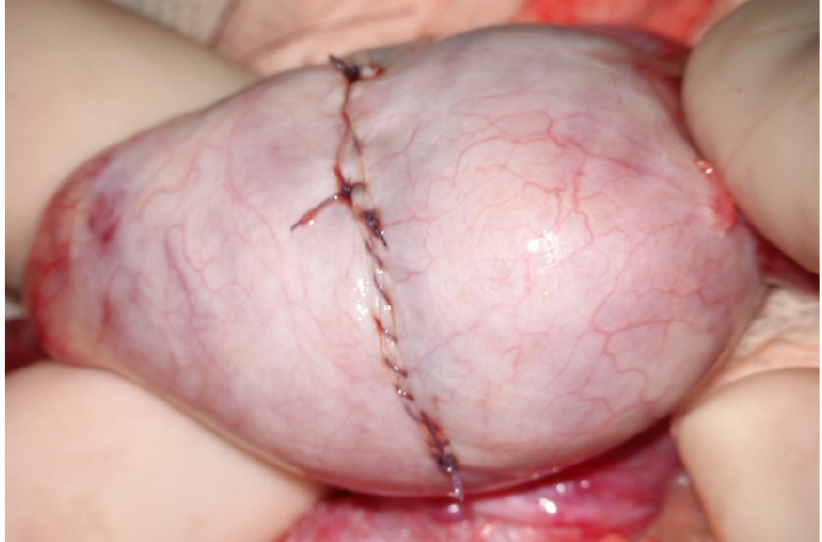
Figure 11. Closure of the albuginea after bivalve opening.